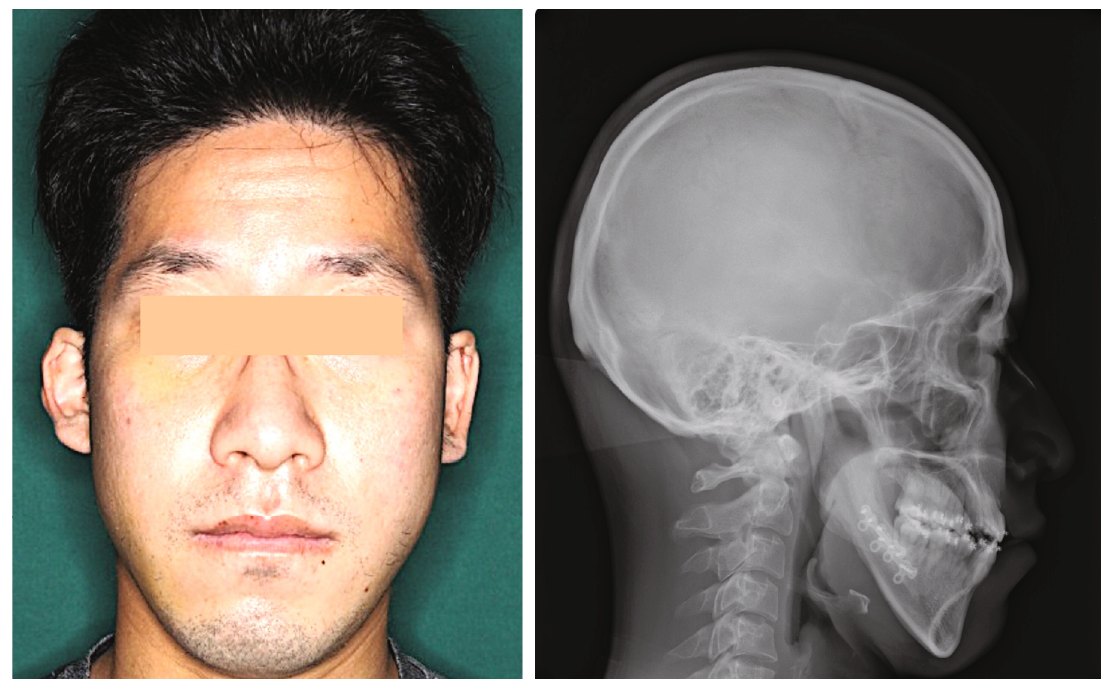
Figure 2: Postoperative facial photograph and lateral cephalometric radiograph. Mandibular deviation and occlusal relationships are improved.